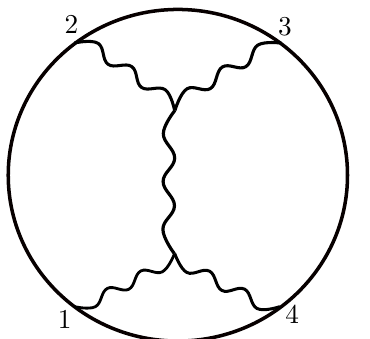
Figure 4. Witten diagram for h V V V V i with on-shell t -channel gluon exchange. Two even and one odd coupling can be used in each vertex; u -channel is similar with 1 and 2